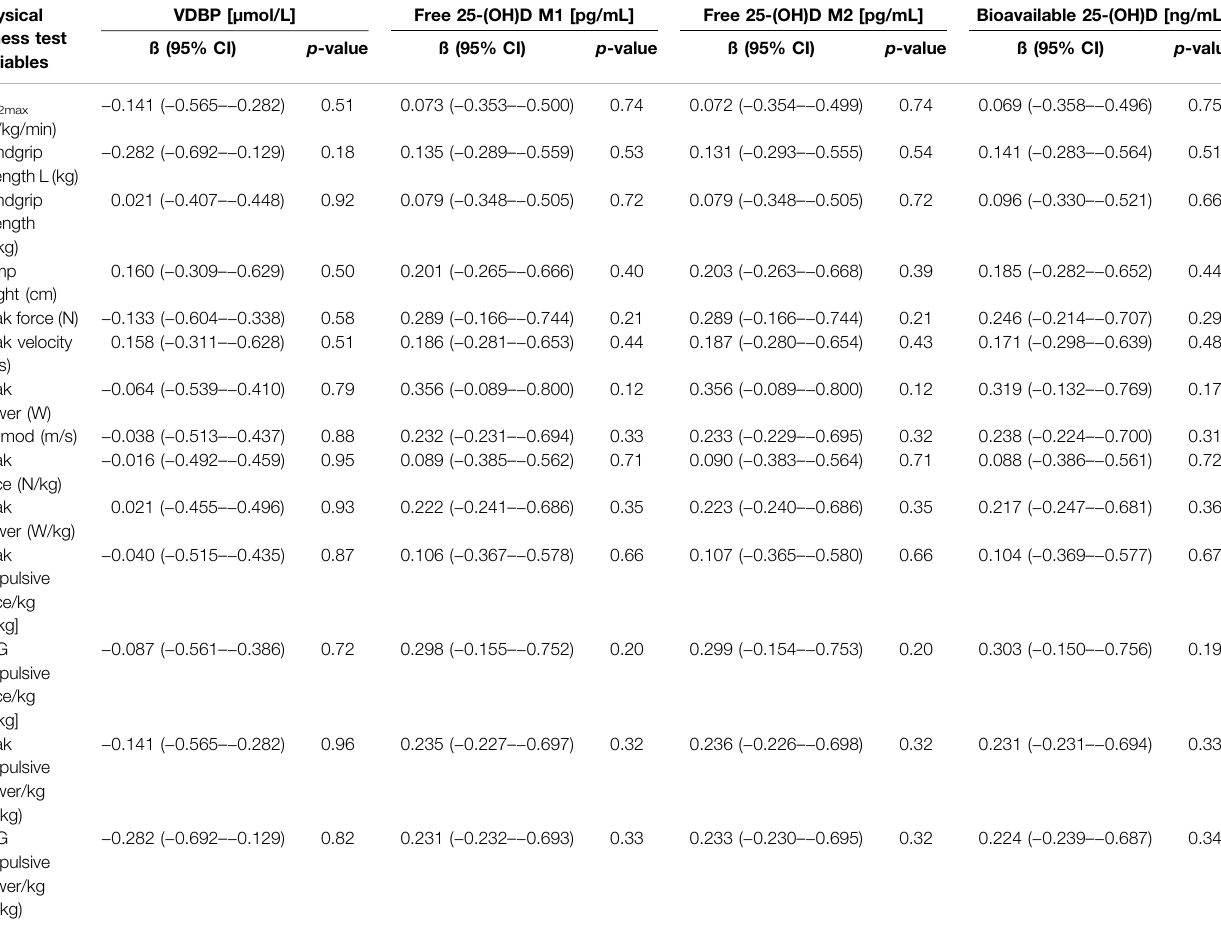
TABLE 5 | Association of athletic performance with VDBP, free, and bioavailable 25-(OH)D concentration by multiple regression analyses* in outdoor players ( n = 24). Physical fi tness